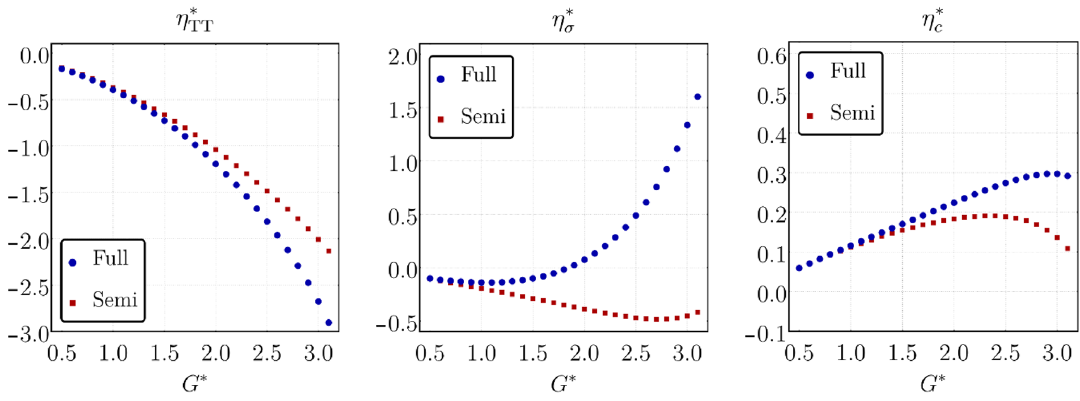
Figure 4 . Anomalous dimensions (cid:17) TT , (cid:17) (cid:27) and (cid:17) c evaluated at the (cid:12)xed point solutions depicted in (cid:12)gure